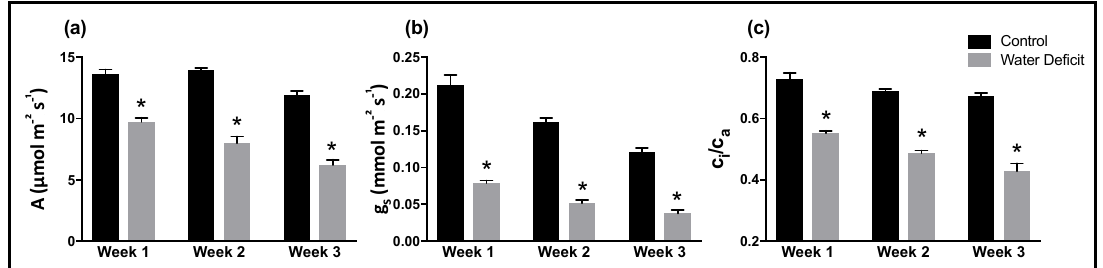
Figure 2. Net photosynthesis (A) ( a ), stomatal conductance (g s ) ( b ) and the ratio of intercellular CO 2 concentration to atmospheric CO 2 concentration (C i / C a) ( c ) for soybean plants subjected to drought (grey columns) and control (black columns) conditions over a period of 3 weeks. A total of 4 plants were measured every week and for each treatment. Individual plants were measured 3 times over a span of 4 h. Bars represent the standard error from the mean ( n = 4). Asterisk (*) indicates significant difference between the drought and corresponding control column ( p < 0.05).